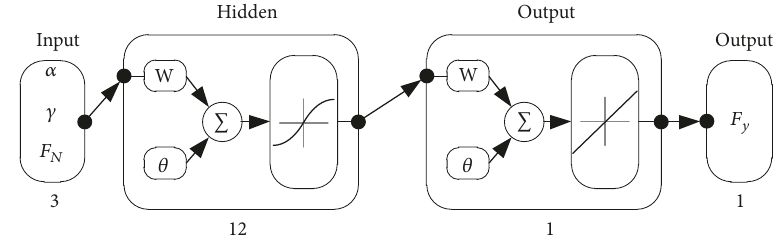
Figure 8: Structure of adopted neural network.